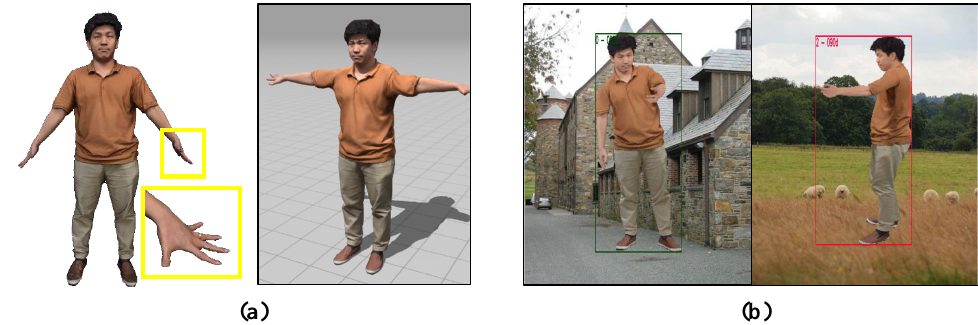
Figure 5. Avatar-based data augmentation: ( a ) example of a reconstructed, and rigged virtual avatar; and ( b ) motion retargeting for viewpoint